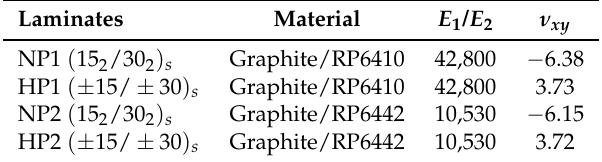
Figure 16. Stiffness coefficients as a function of slenderness for ( 15/5 ) s ( a – e ) and stiffness ratio k 4,11 / k 4,4 ( f ). Table 5. Stacking sequencies presented by Peel [64] stiffness and equivalent Poisson